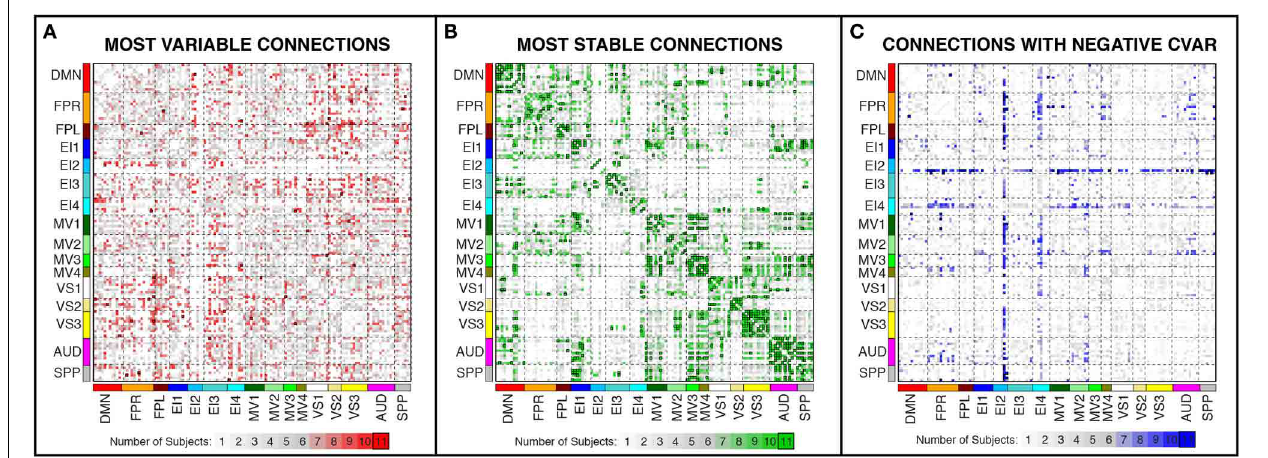
shown in Figure 6 (most variable), Figure 8 (most stable), and Figure 11 (negative CVAR). Connections that were classified in the same group for